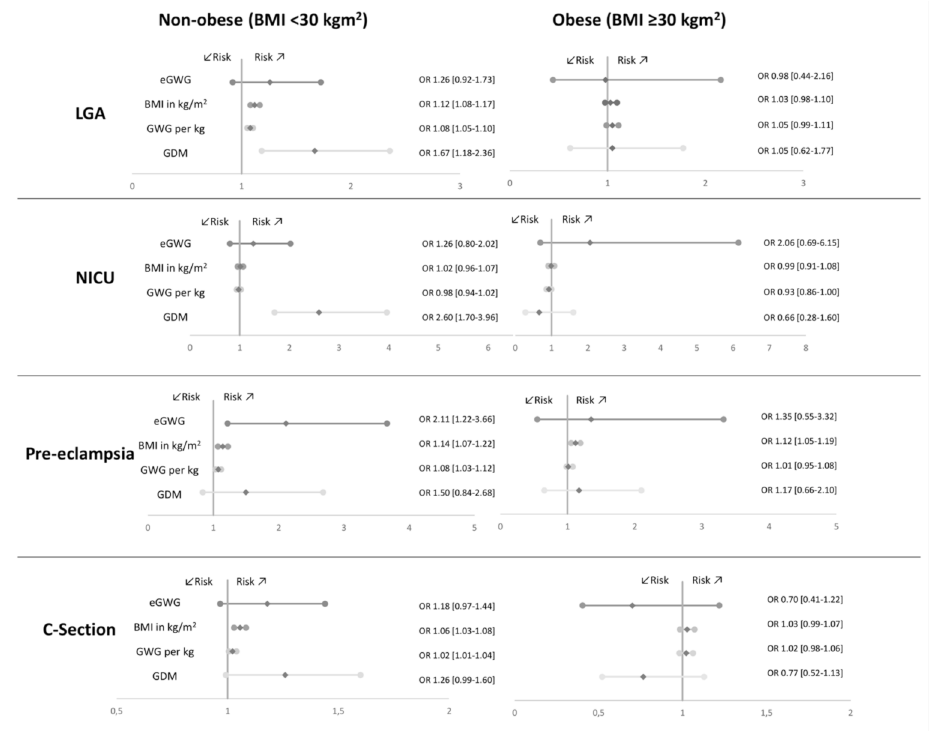
Figure 2. Adjusted odds ratios (ORs) of perinatal complications for the non-obese and obese sub- groups: large for gestational age (LGA), neonatal intensive care unit (NICU) admission, pre-eclampsia and C-Section. Results from the logistic regression models adjusted for maternal age, parity, gesta- tional age and sex of the newborn are presented: excessive gestational weight gain (eGWG), body mass index (BMI), gestational weight gain (GWG) per kg and gestational diabetes